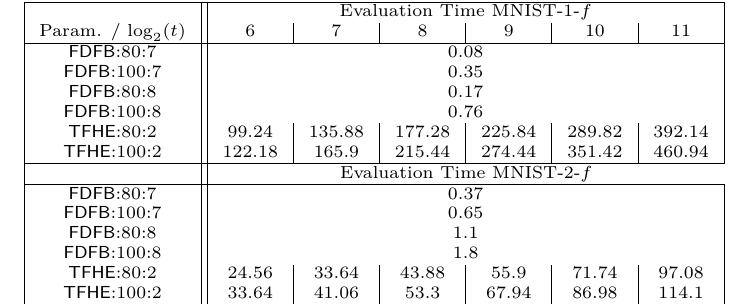
Table 7: Performance for evaluating neural networks. The table contains the times to evaluate the MNIST-1- f and MNIST-2- f neural networks. The time to evaluate the neural networks is given in hours. Due to extremely high execution times, we only present estimates for TFHE , which we base on Table 6.